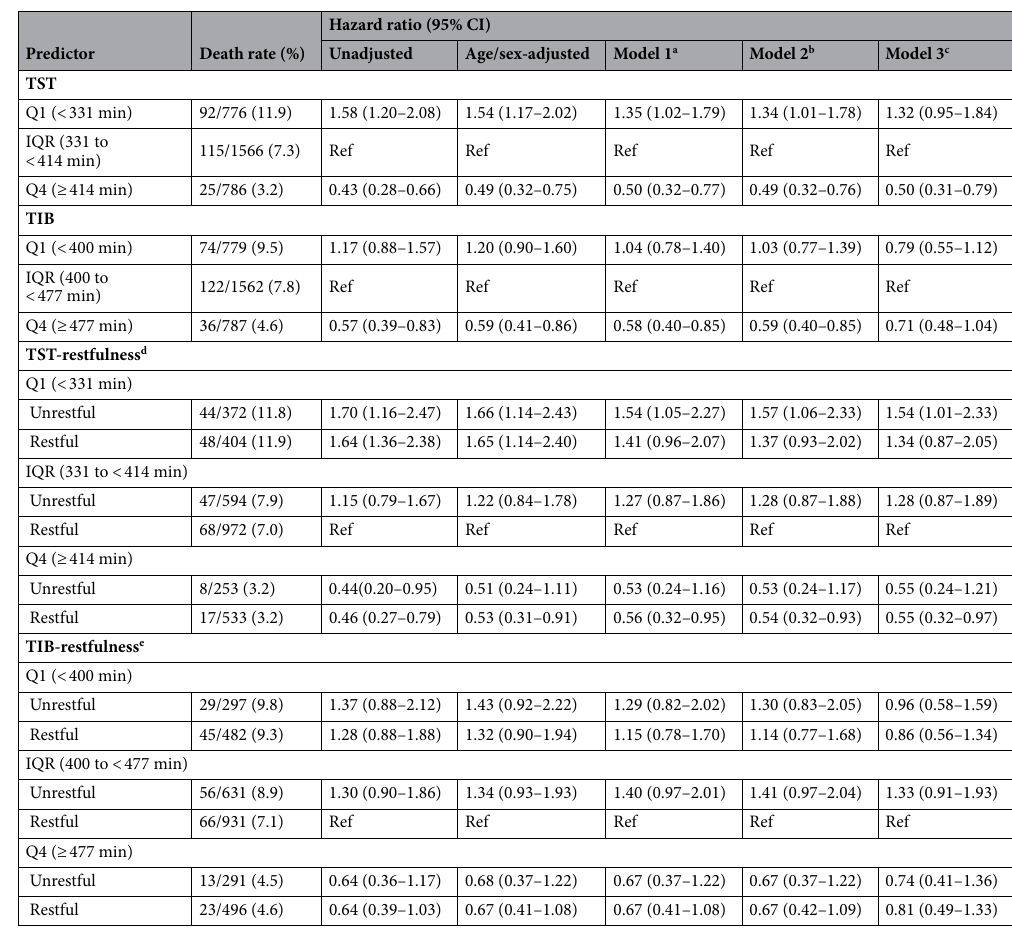
Table 3. Mortality hazard ratios from cox regression for middle-aged adults (n = 3128). CI confidence interval, IQR interquartile range, Q1 lowest quartile, Q4 highest quartile, Ref reference, TIB time in bed, TST total sleep time. a Model 1 included age, sex, race (Caucasian vs. other), body mass index, smoking status, apnea hypopnea index with 4% desaturation, sleep time with saturated oxygen below 80%, stroke, myocardial infarction, hypertension, diabetes, and physical functioning standardized score on the Short Form 36 Health Survey. b Model 2 included Model 1 plus antidepressants, benzodiazepines, Epworth Sleepiness Scale score, number of daytime naps per week, weekend-weekday difference in habitual sleep duration, insomnia or poor sleep, and percent time in rapid eye movement sleep. c Model 3 included Model 2 plus TIB in TST/TST-restfulness models or TST in TIB/TIB-restfulness models. d P = 0.85 for interaction between categorical TST and sleep restfulness variables. e P = 0.91 for interaction between categorical TIB and sleep restfulness